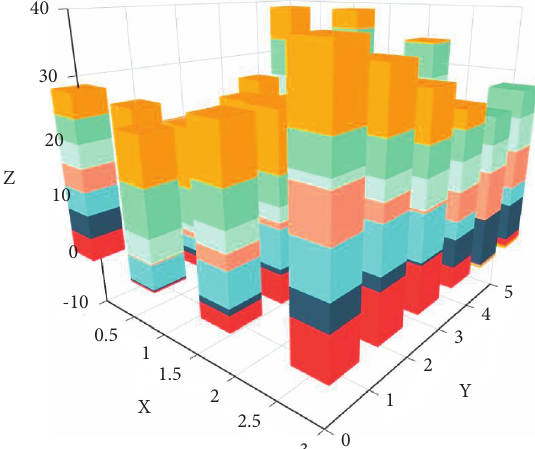
Figure 8: The conclusion expression of logistic regression analysis model